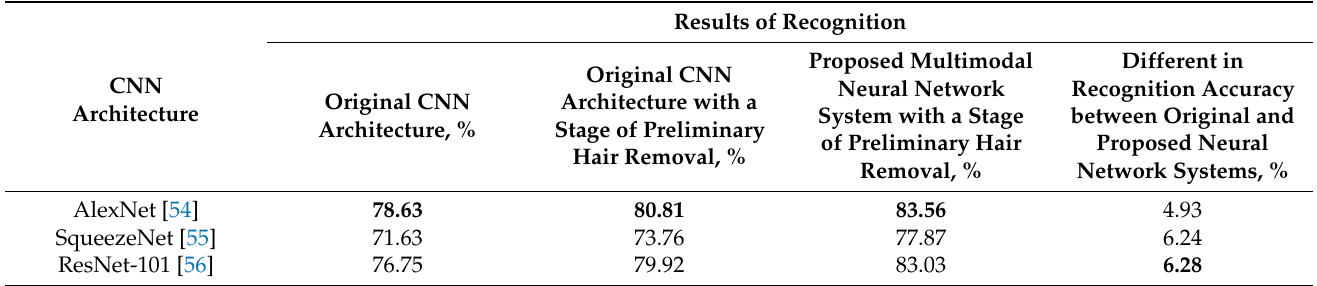
Table 4. Results of modeling a multimodal neural network classification system for dermatoscopic images of pigmented skin lesions. Bold font indicates the best result in each column of the table.